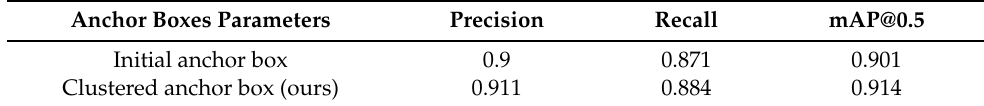
Table 4. Performances of different anchor boxes parameters.